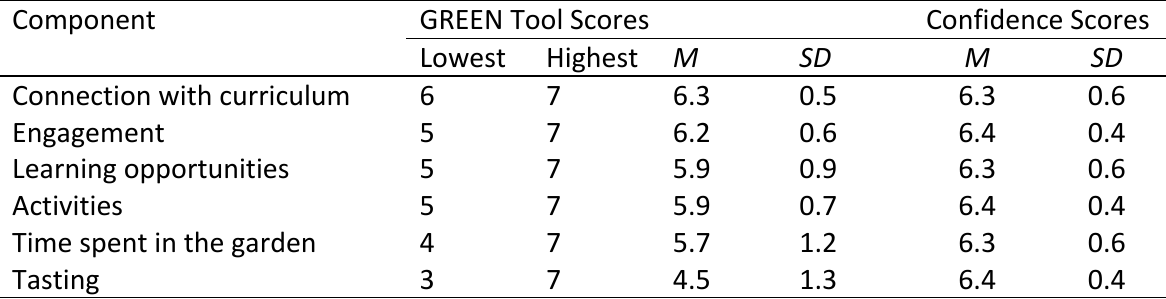
Table 5 Summary and Comparison of GREEN Tool and Confidence Scores for Domain 3 (n = 15) Component GREEN Tool Scores